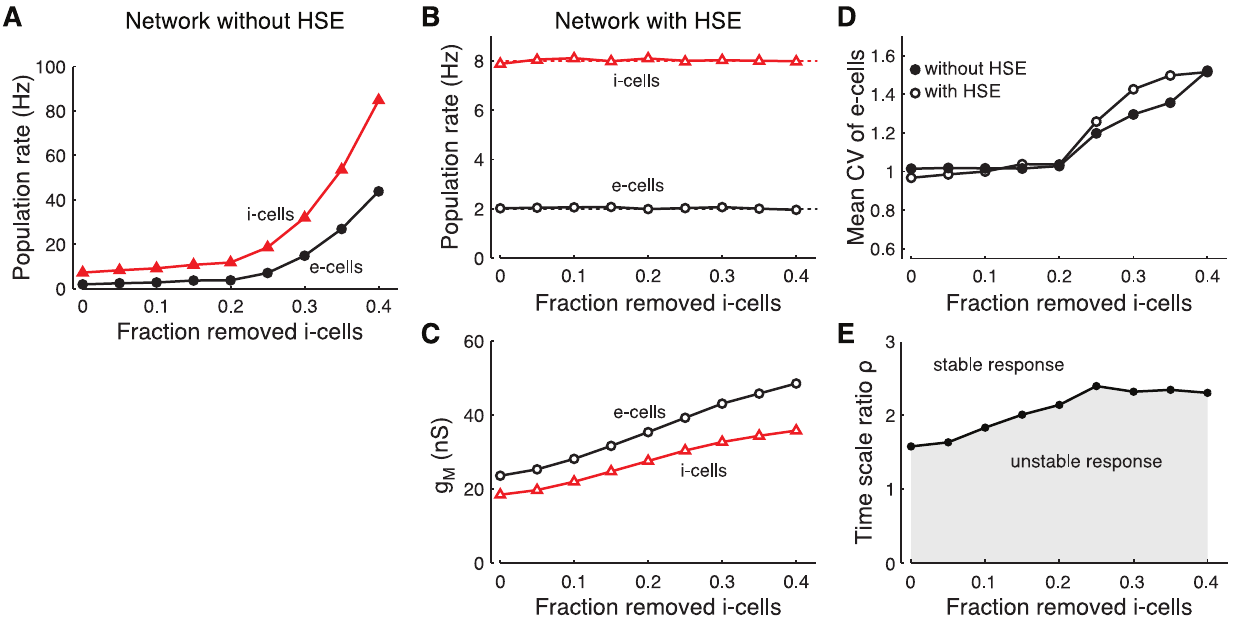
Figure 8. Adapting to loss of inhibitory cells from the recurrent network. Response of the recurrent network when up to 40% of the inhibitory cells are removed. A: Median firing rate of e-cells (circles) and i-cells (triangles) in the network without HSE. B: Median firing rate of e-cells (circles) and i-cells (triangles) in the network with HSE. Dotted lines at 2 and 8 Hz give target rates of both cell types. C: Population mean g M of the e- cells (circles) and i-cells (triangles) in the network with HSE. D: Population mean coefficient of variation of the interspike intervals (CV) of the e-cells in the network without HSE (filled circles) and in the network with HSE (open circles). E: Required ratio of adaptation time scales r for stable adaptation dynamics when the network is perturbed from its adapted state (characterized in panels B and C). The perturbation consists of a 0.3 kHz step increase of the external drive to all cells in the network. The same criterium for stability of the adaptation dynamics is used as in figure 2.